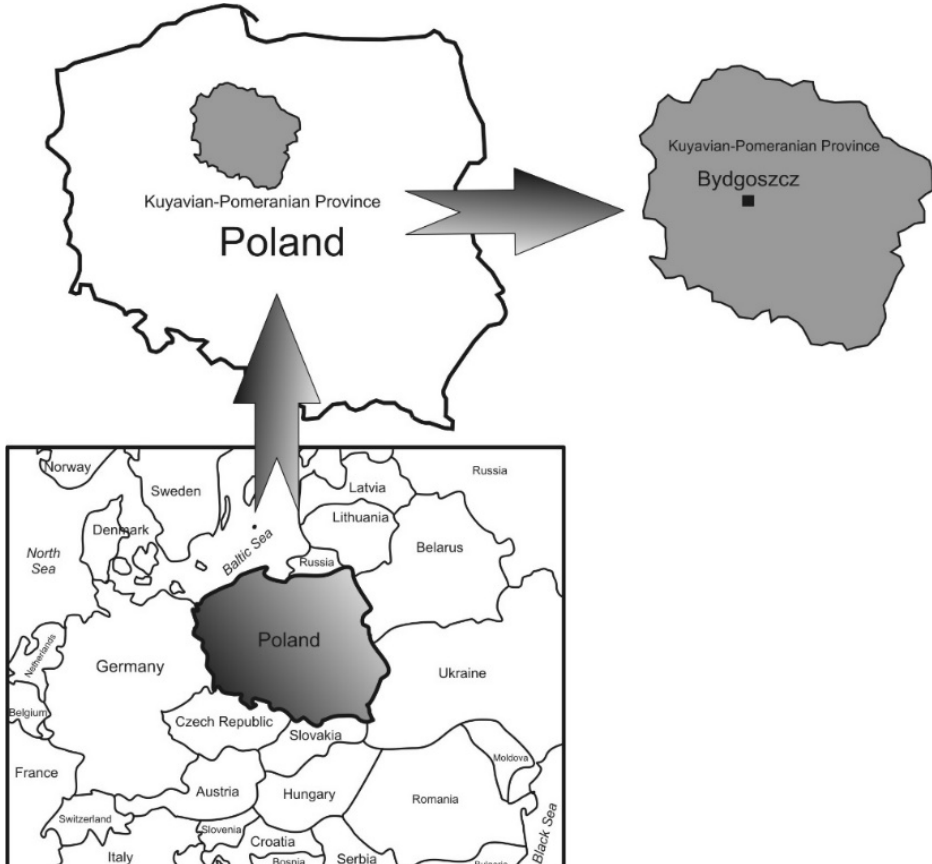
Figure 1. Geographical location of the Bydgoszcz region in Poland and Europe.